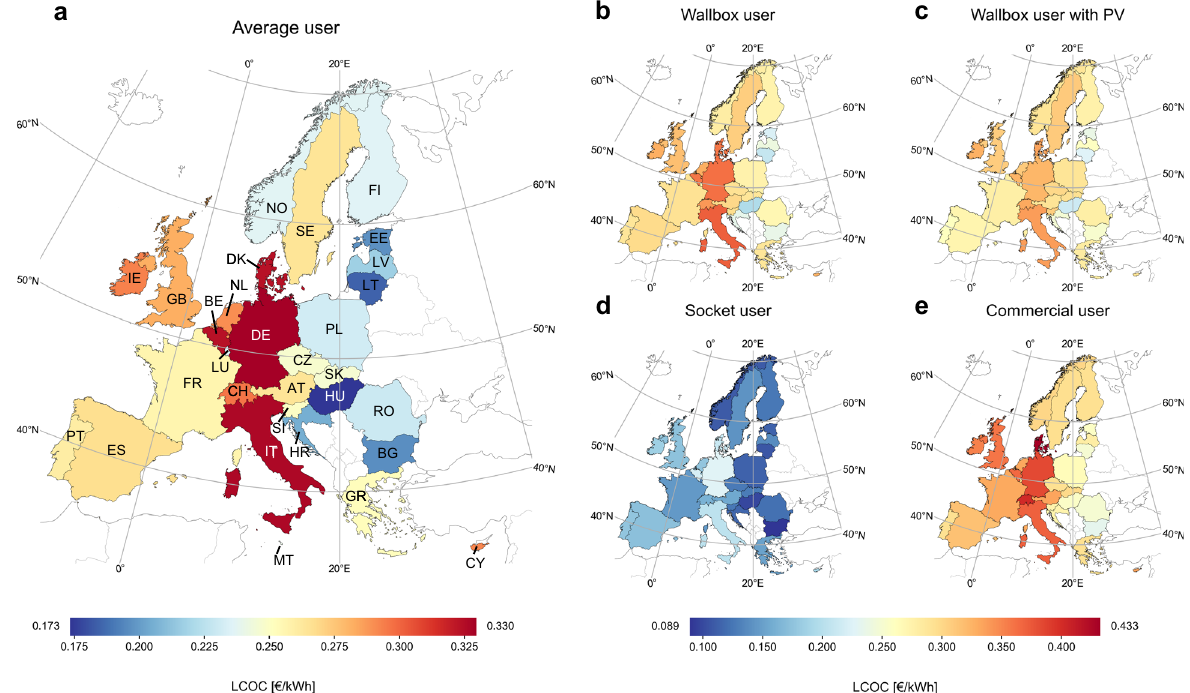
Fig. 2 | Map of LCOC results in € per kWh of energy charged for fi ve user pro fi les.a Averageuser LCOCresults.Forfullnamesofcountries,pleaseseeFig.3. b Wallbox user LCOC results. c Wallbox user with PV LCOC results. d Socket user LCOC results. e Commercial user LCOC results. Results are displayed for all 30